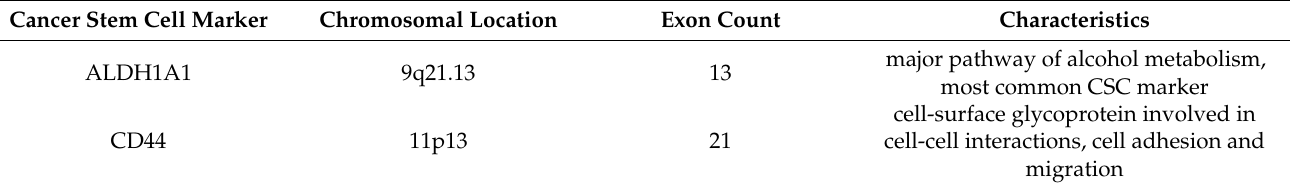
Table 2. Common Cancer Stem Cell Markers in Oropharyngeal Cancer